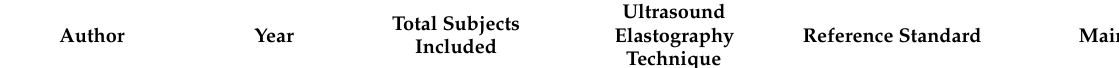
Table 1. Ultrasound elastography of intestines in Crohn’s